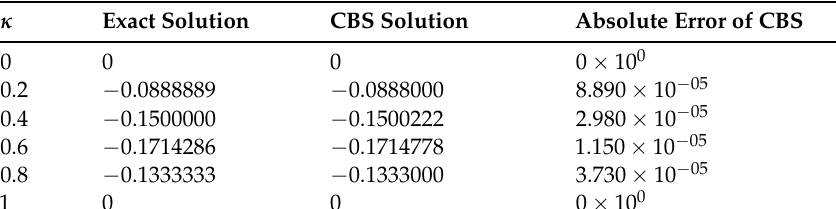
Table 3. Analyzing exact solution and CBS solution of problem 1 at h = 1